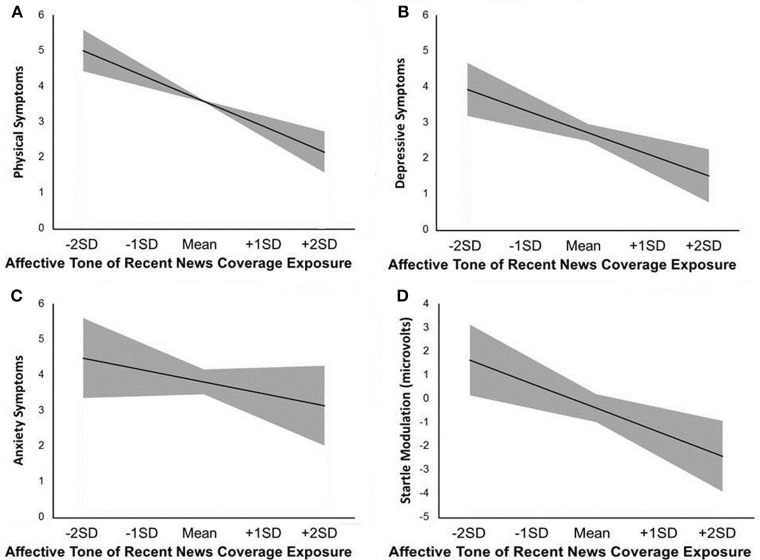
Simple slopes representation of models predicting changes in mental health symptoms and startle potentiation from changes in the affective tone of recent news coverage exposure. Models predicting physical symptoms (A), depressive symptoms (B), anxiety symptoms (C), and startle modulation (D) from affective tone of recent news coverage exposure. Values for affective tone indicate the proportion of affective words that were positive and negative in the recent news coverage (i.e., over the previous 2 weeks) to which participants reported being exposed. Higher values for affective tone indicate increases in the proportion of positive affective words and decreases in the proportion of negative affective words, while lower values for affective tone indicate decreases in the proportion of positive affective words and increases in the proportion of negative affective words. Model slopes are represented by a black line, with ±1 standard error of the slope and intercept for each model shown as a gray shaded area. SD stands for standard deviation.